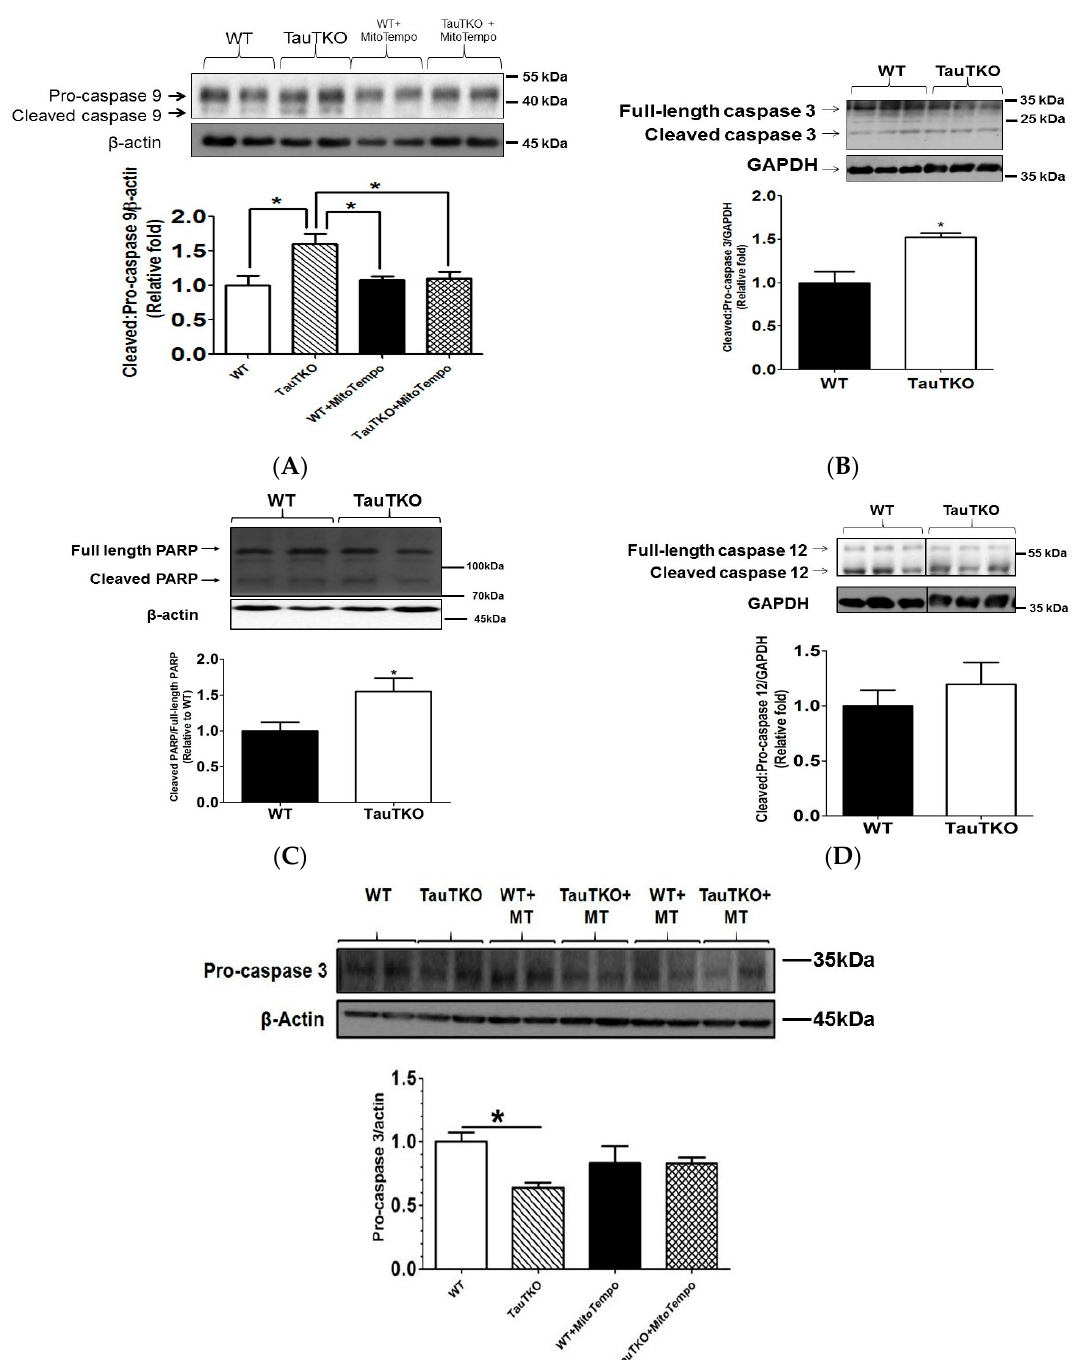
Figure 5. Taurine depletion induces apoptosis. Total heart lysates of 3-month-old TauTKO and WT hearts were subjected to western blot analyses of the active forms of caspase 9, caspase 3 and caspase 12, as well as the inactive pro-caspase forms of the three proteases ( A – E ). In ( A ), the data are expressed as the ratio of active caspase 9/pro-caspase 9 while in ( B ), the data are depicted as the ratio of cleaved caspase 3/pro-caspase 3. In ( C ), the data are expressed as cleaved PARP levels. In ( D ), the ratio of cleaved/pro-caspase 12 is shown. In ( E ), TauTKO and WT mice were treated with the mitochondria- specific antioxidant, MitoTempo, for 7 days and changes in the levels of the inactive pro-caspase 3 zymogen were determined. Each panel contains a representative gel. The representative bands for WT and TauTKO were spliced from one original gel and the splice junction is indicated by the black splicing line. Values shown represent means ± SEM of 6–9 hearts. All values are expressed relative to WT, where WT is fixed at 1.0. * p < 0.05.